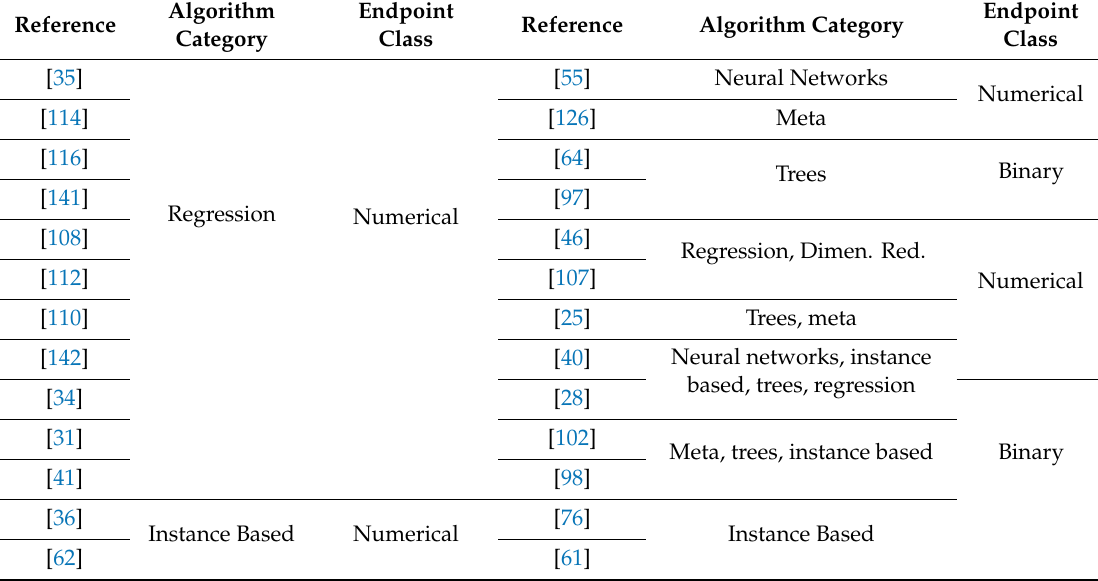
Studies performing goodness-of-fit, robustness, and predictivity and assessing the applicability